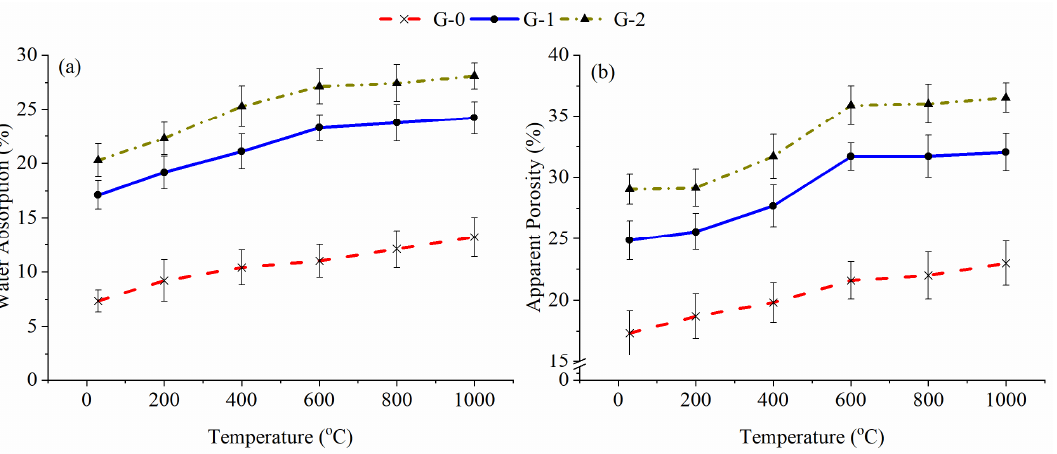
Figure 8. ( a ) Water absorption and ( b ) apparent porosity of G-0, G-1 and G-2 before and after being subjected to high temperatures.